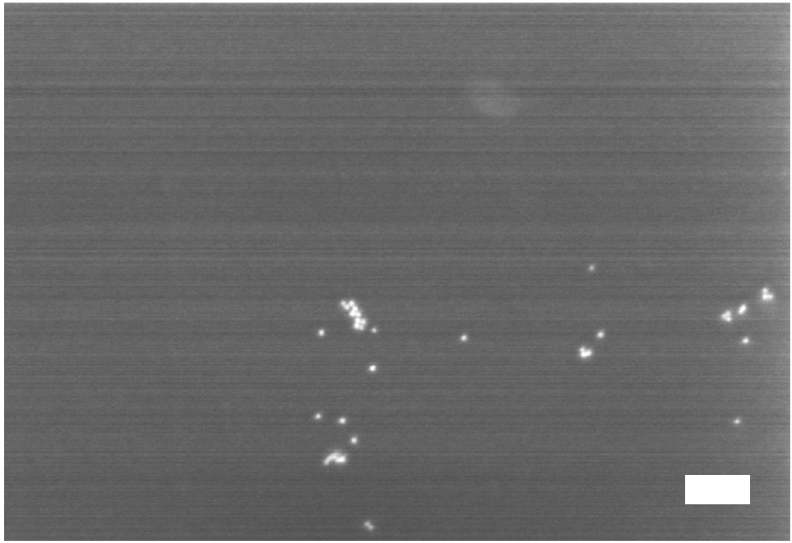
Figure 2. Attachment of gold particles on the native silicon surface without the S2VP coating layer. The native silicon was immersed in the solution of 10 nm gold nanoparticles for 2 h. The scale bar is 100